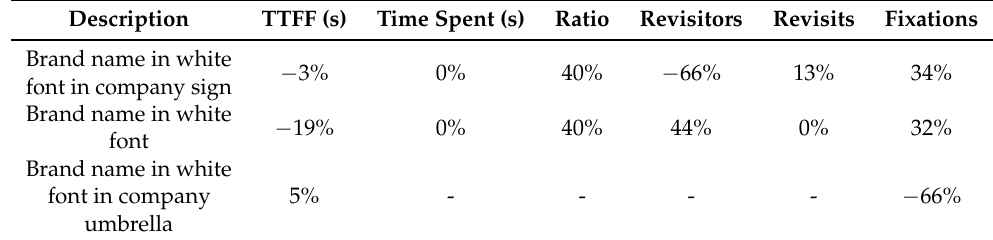
Table 9. Area of interest (AOI) metrics percentage decrease: shared AOIs from old to new website design. Note: negative percentages presented an increase of − 1*percentage. Percentages were truncated to no decimal